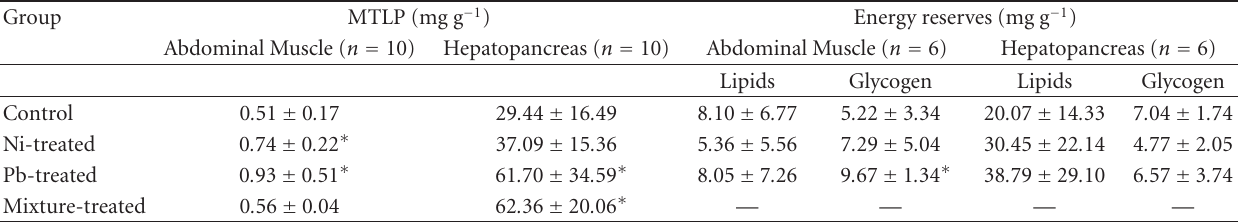
Table 1: MTLP concentration and energy reserves (mean ± standard deviation) in control and metal-treated in abdominal muscle and hepatopancreas from P. vannamei .